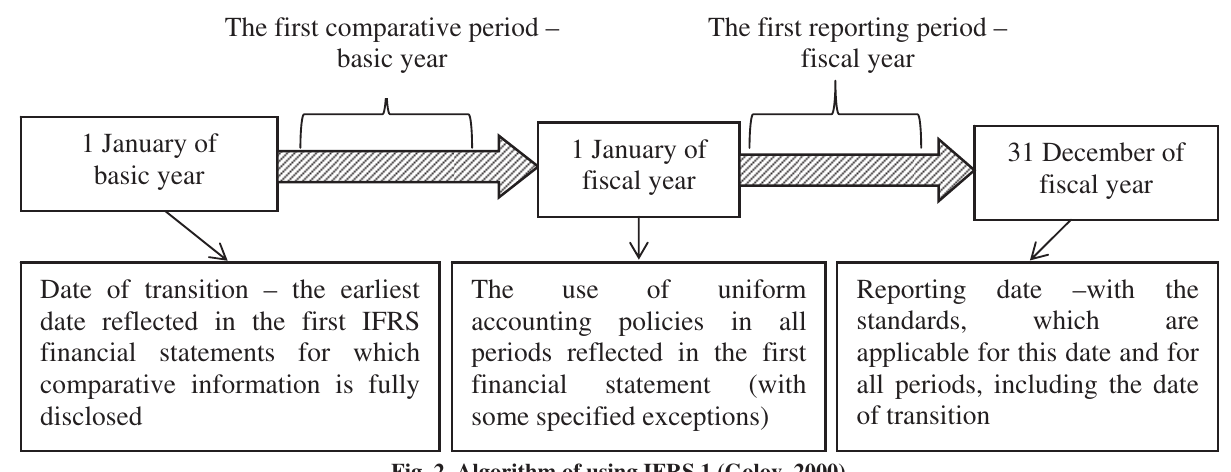
Fig. 2. Algorithm of using IFRS 1 (Golov,